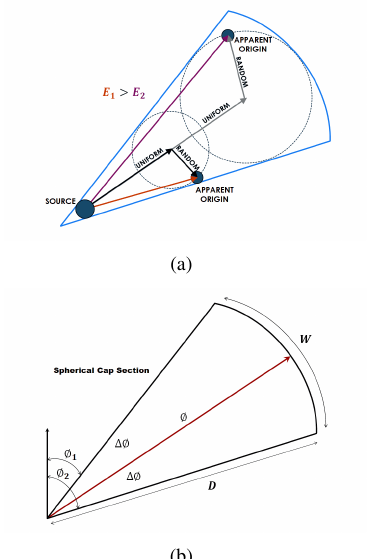
Figure 1. Drift-di ff usion deflection of UHECR from a source. (a) Two events having traveled through uniform and random magnetic fields. The purple vector represents the lower en- ergy event spherical arc and the red vector is a higher energy event. Random and uniform field components describe the av- erage magnetic field perpendicular to the surface of the field of view (FOV) sphere. Dashed circles represent possible random field deflections. (b) A spherical cap section, “wedge,” best en- compasses the likeliest positions. Pointing direction is the spher- ical arc φ , width is ∆ φ , and D is the maximum angular